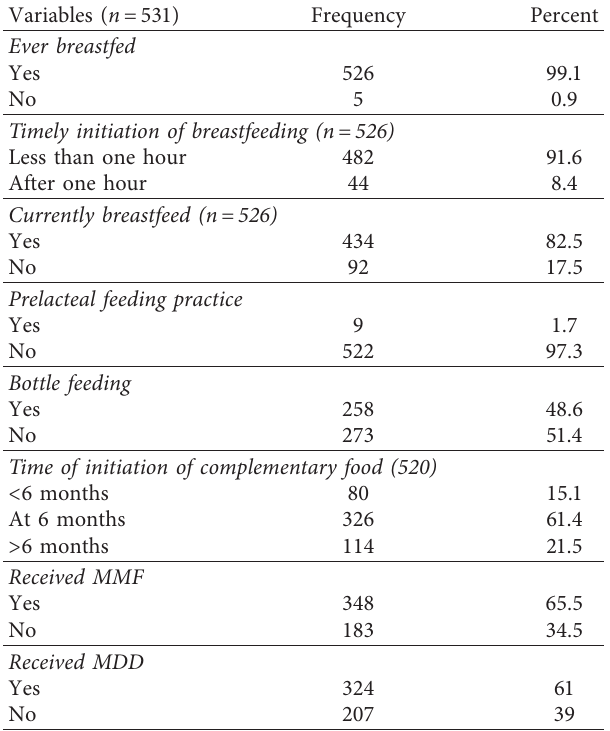
Table 2: Distribution of selected IYCF indicators among infants and young children aged 6–23 months in Debre Berhan Town, North Shewa Zone, 2018.